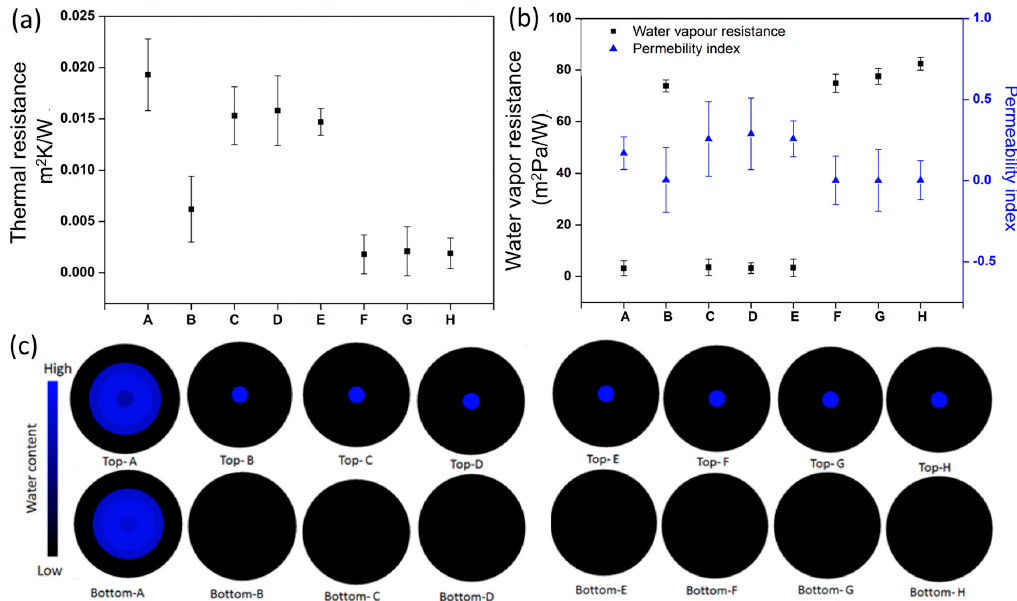
Figure 5. Comfort analysis of the as-coated cotton fabrics: ( a ) Thermal resistance; ( b ) water vapor resistance with permeability index; ( c ) moisture management test (MMT) profiles.